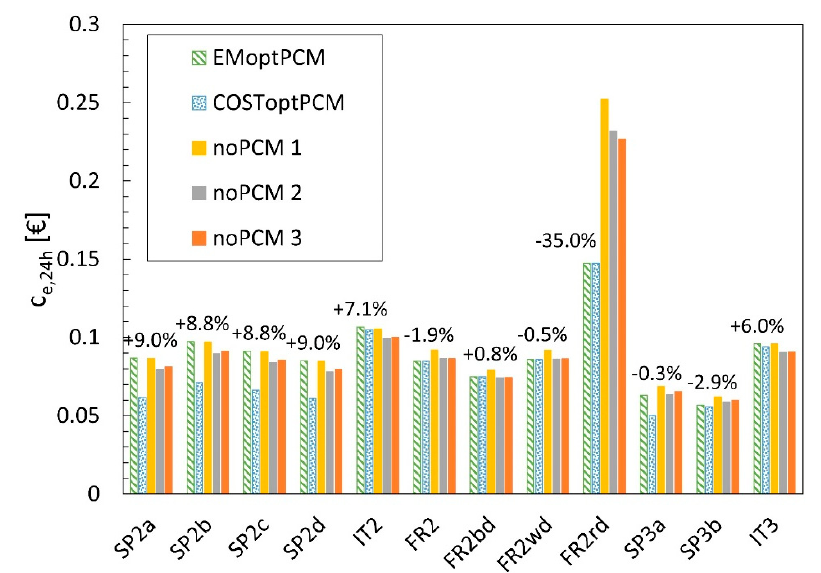
Figure 8. Daily running cost of the cabinet refrigerator working with scheduled hysteresis obtained by carbon emission optimization for the cases studies considered in Maiorino et al. [44]. The percentage values above each bar represent the difference between the daily running cost calculated with a hysteresis scheduling which optimizes daily carbon emission, and the minimum daily running cost obtained simulating the refrigerator without PCM with a fixed hysteresis.